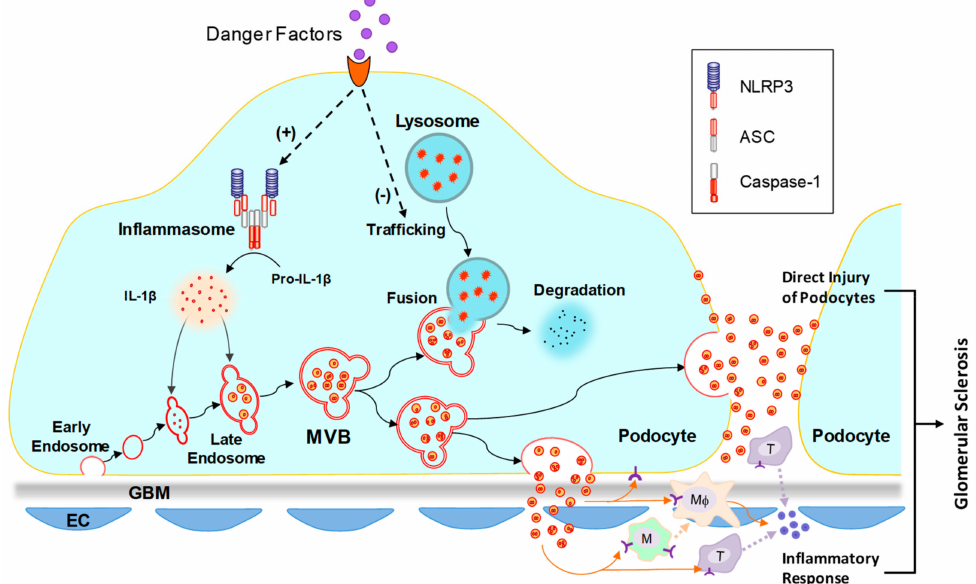
Figure 3. Mechanism of inflammatory exosome release in podocytes. It has been reported that in podocytes, pathological stimuli may induce inflammasome activation and lysosome dysfunction. Activated inflammasome produces proinflammatory cytokines, such as IL-1 β and IL-18. Lysosome dysfunction leads to reduced MVB degradation and increased exosome release. The proinflammatory cytokines in podocytes may be released through exosome release. The released inflammatory exosomes may induce direct injury of podocytes and inflammatory response, leading to the development of glomerular sclerosis. NLRP3, nucleotide-binding oligomerization domain-like receptor containing pyrin domain 3; ASC, adaptor molecule apoptosis-associated speck-like protein containing a caspase recruitment domain; IL-1 β , interleukin-1 β ; GBM, glomerular basement membrane; EC, endothelial